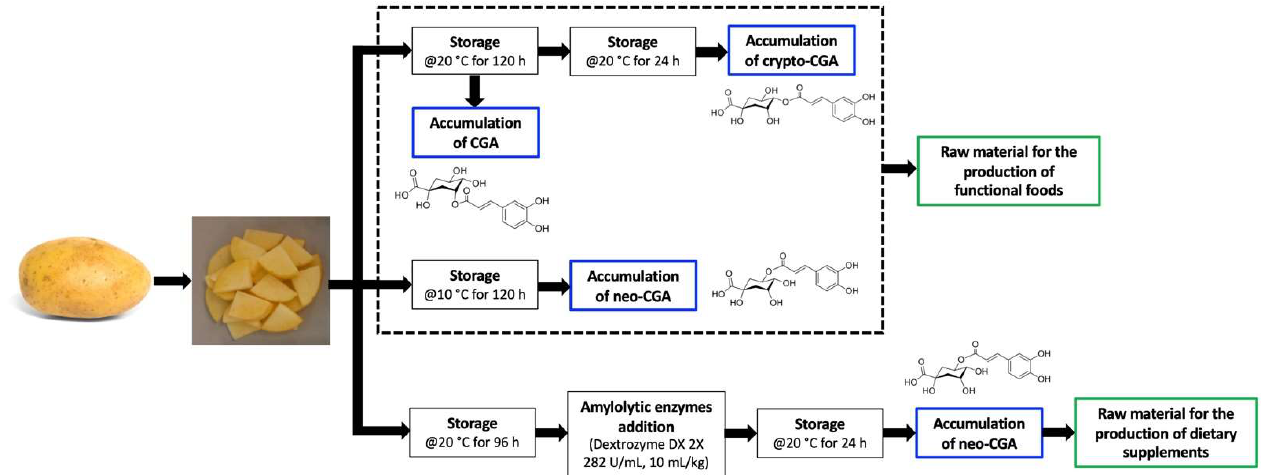
Figure 2. Postharvest wounding stress and storage temperature conditions to trigger the accumulation of specific chlorogenic acid (CGA) isomers in potatoes. The tissue with an increased content of CGAs could be used as raw material to produce functional foods or dietary supplements.